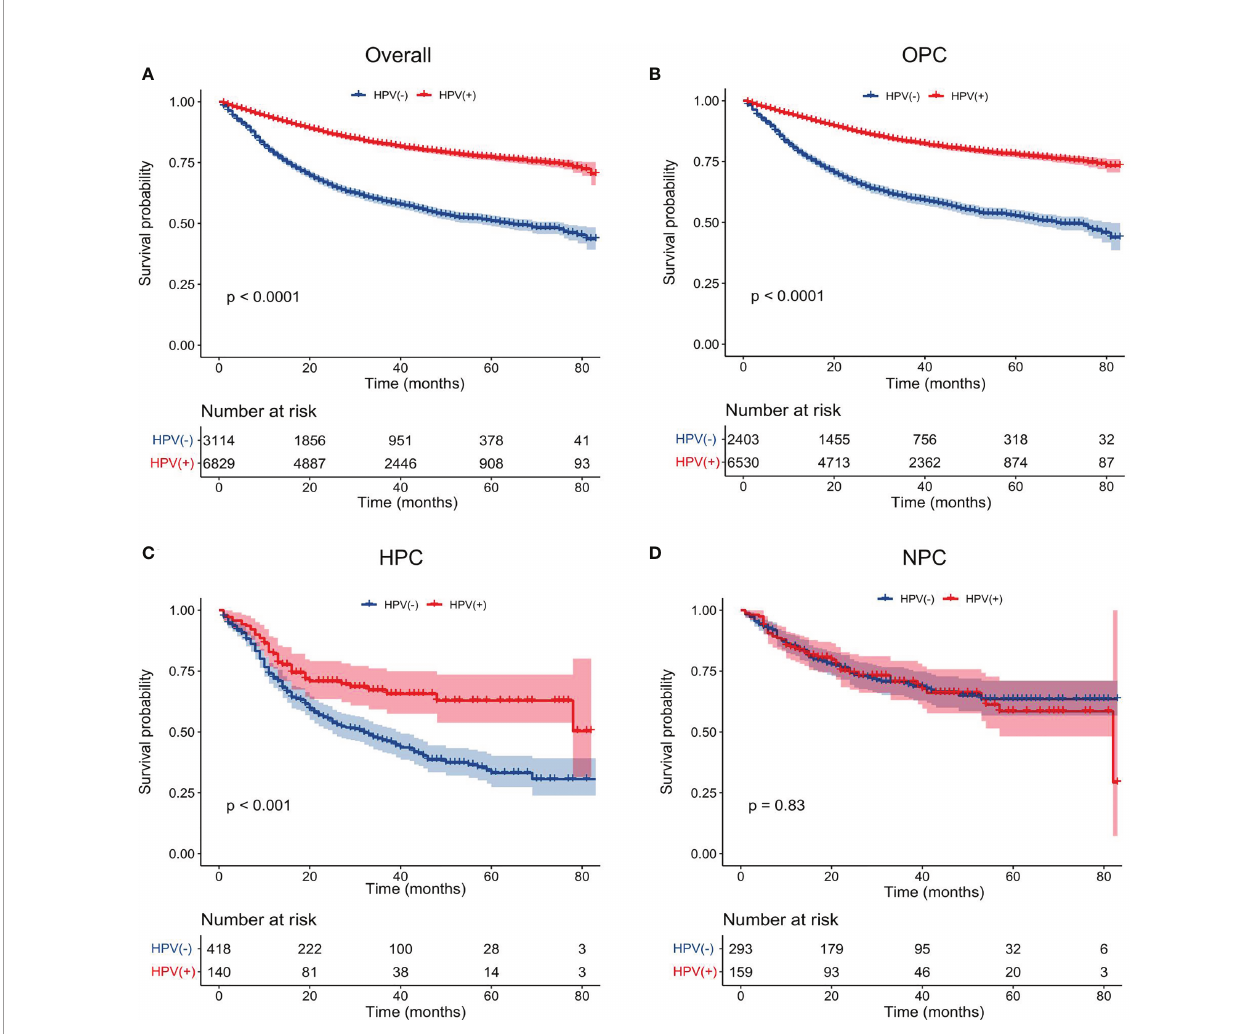
FIGURE 2 | Impact of HPV infection on the overall survival of HNSCC patients arising from different anatomical subsites. K-M plots of the overall survival were shown for: (A) total population, (B) oropharyngeal carcinoma, (C) hypopharyngeal carcinoma, (D) nasopharyngeal carcinoma. HPV, human papillomavirus; HNSCC, head and neck squamous cell carcinoma; OPC, oropharyngeal carcinoma; HPC, hypopharyngeal carcinoma; NPC, nasopharyngeal carcinoma.